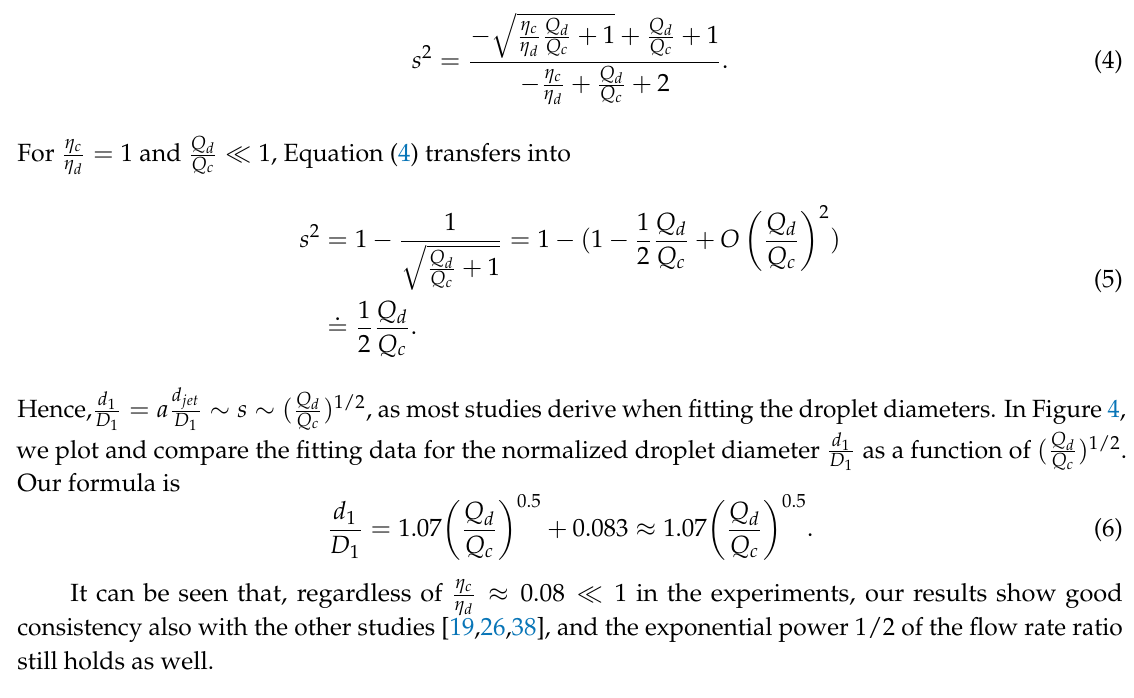
Figure 4. Fitting data of the normalized droplet diameter d 1